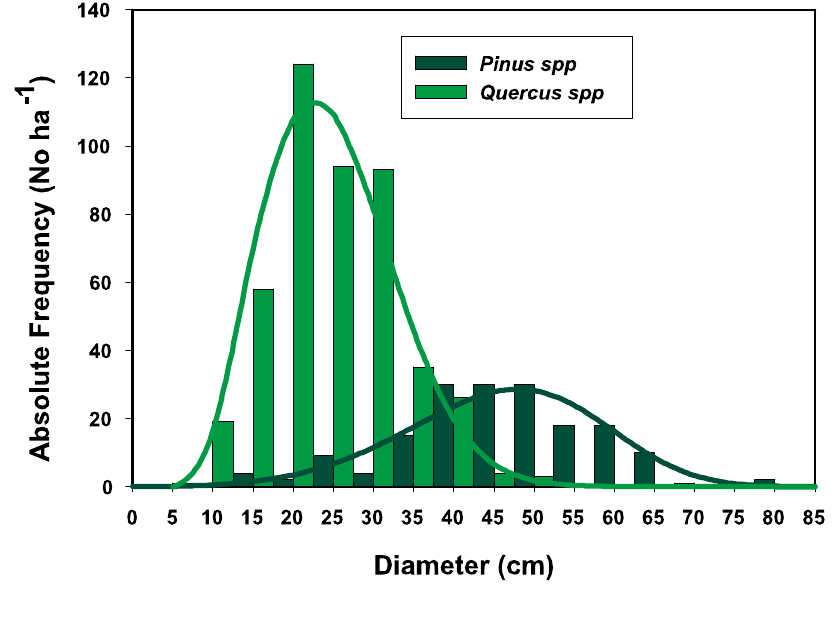
Figure 1. An example of the maximum likelihood two-parameter Weibull density function fitted to diameter structures of pines and